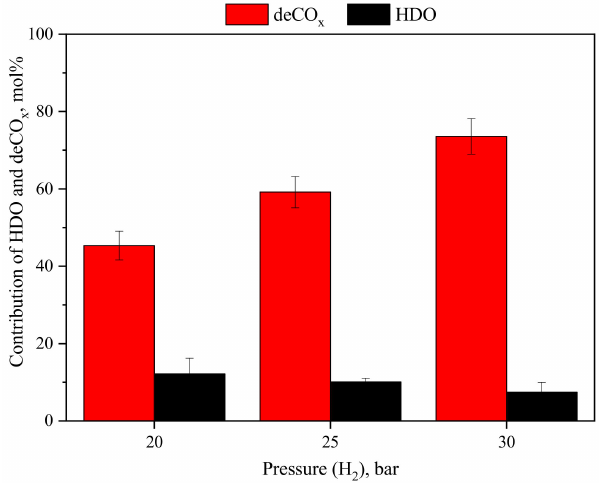
Figure 5. Contribution of HDO and DeCO x under di ff erent H 2 pressure.